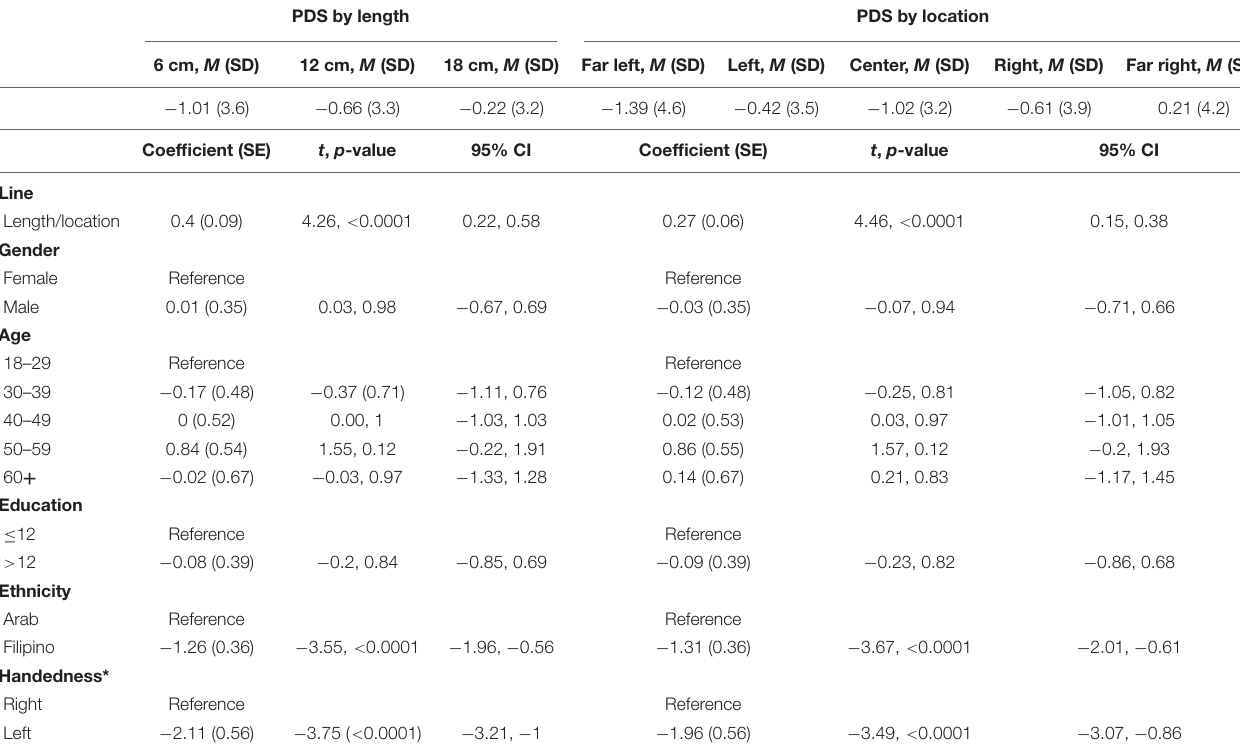
TABLE 2 | Mixed effects model results for the PDS according to “line” length and